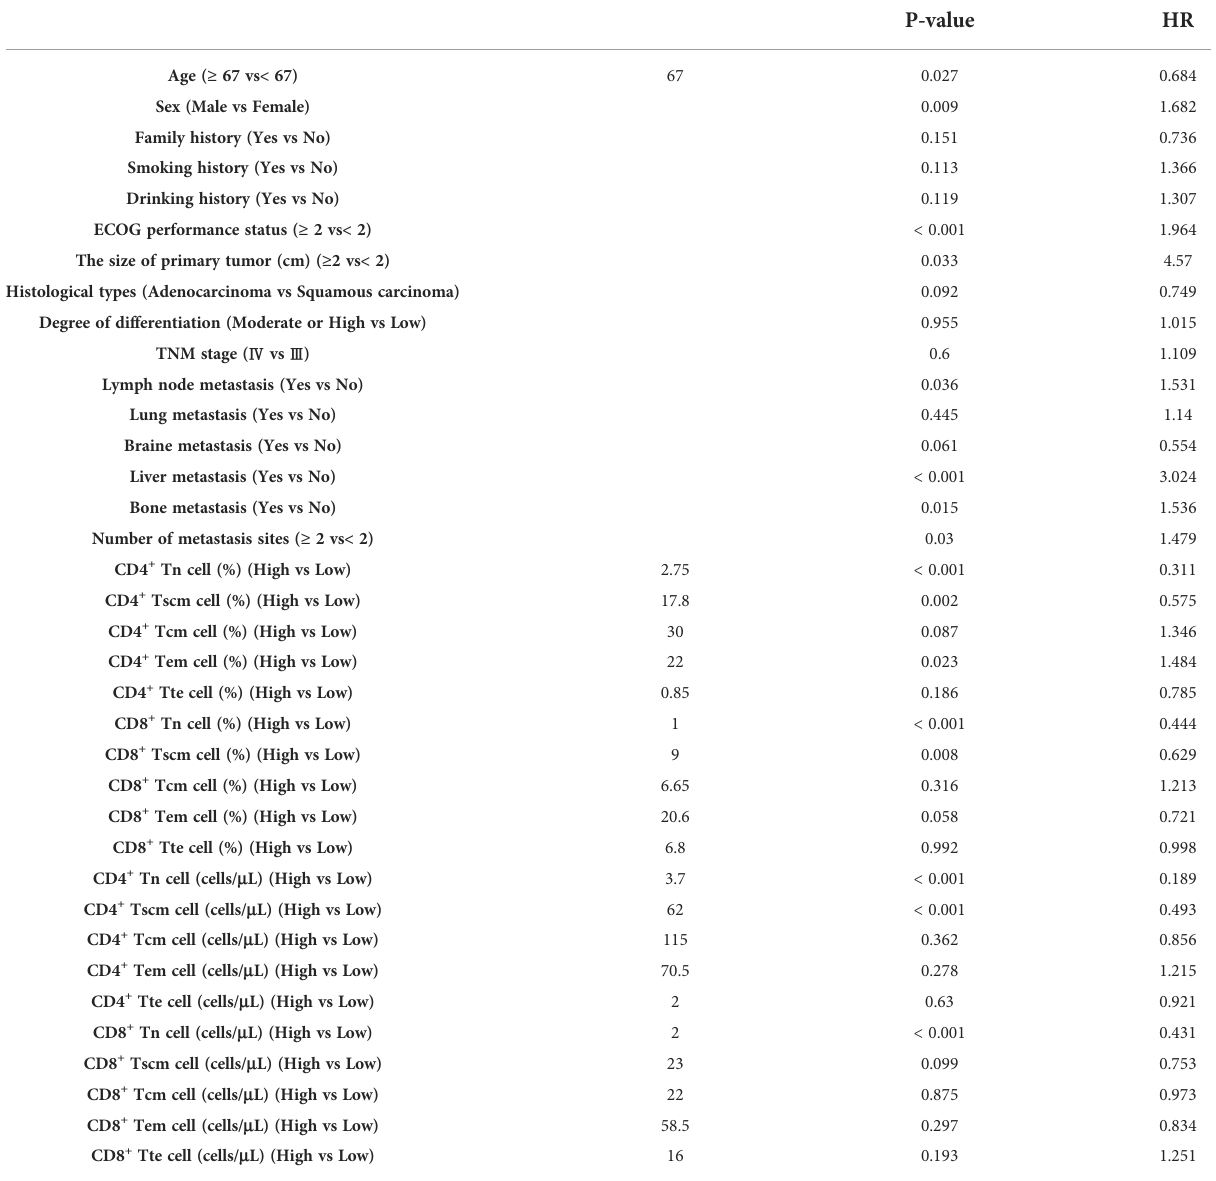
TABLE 3 Univariate analysis on PFS of